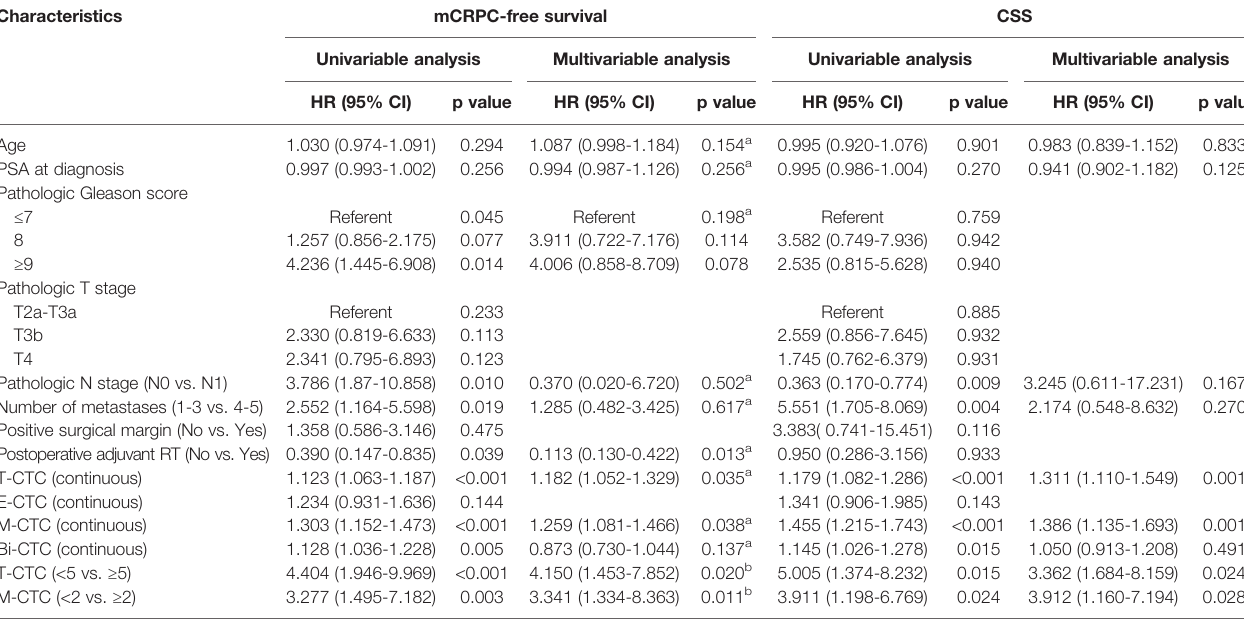
TABLE 3 | Univariable and multivariable Cox analysis for mCRPC-free survival and CSS.